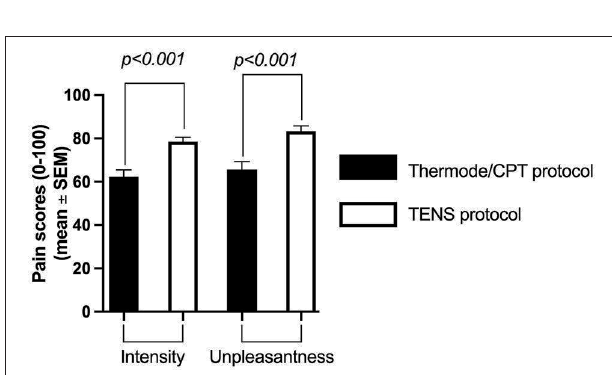
FIGURE 3 | Average pain intensity and unpleasantness of pain induced by the CS with the thermode/CPT protocol and the TENS protocol. CPT, cold pressor test; TENS, transcutaneous electrical nerve stimulation.